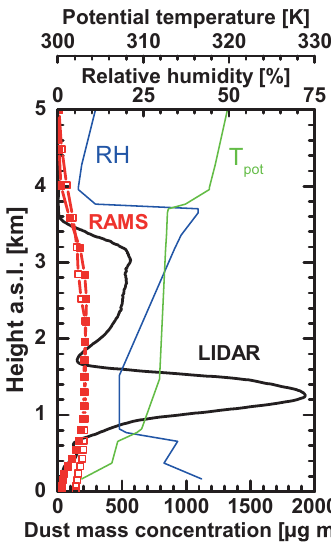
Figure 5. Mean dust mass concentration observed with lidar (thick solid black line) at Limassol on 7 September, 19:00–20:00UTC, and dust profiles simulated with RAMS (normal run with 20km horizontal resolution) for Limassol, on 7 September, 18:00UTC (closed red squares) and 8 September, 09:00UTC (open squares). Radiosonde observation (launched at the radiosonde station at Atha- lassa near Nicosia on 8 September 06:00UTC) of height profiles of potential temperature ( T pot , thin green curve) and relative humidity (RH, thin blue curve) are in good agreement with the double layer dust structures observed about 12h earlier. The lofted dust layer from 1.7 to 3.6km height was well